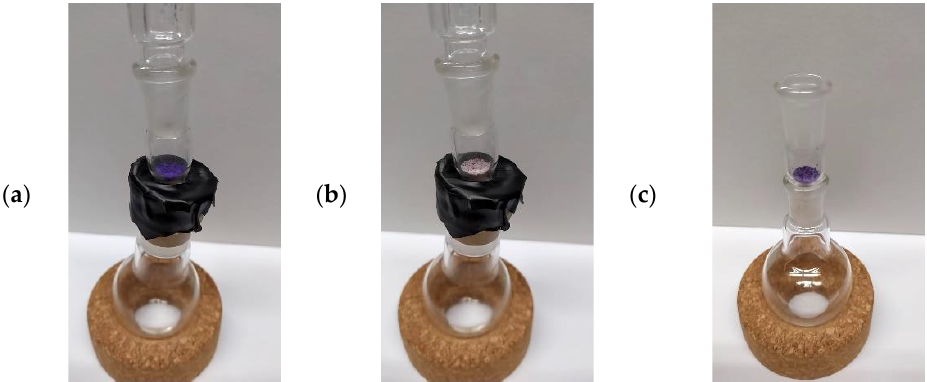
Figure 8. Photographs of Ros4PyMe@SBA after exposure to putrescine (vapor) at time zero ( a ), after 2 min ( b ) and after exposure to air (approximately 2 min) — removal of the amine and open system 2 min ( b ) and after exposure to air (approximately 2 min)—removal of the amine and open system ( c ( c ).